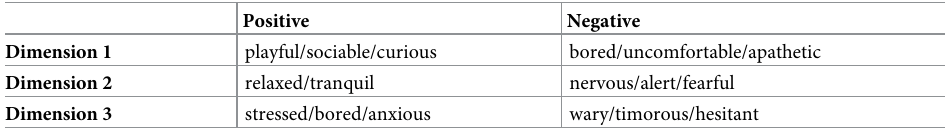
Table 1. List of terms summarising the highest positive and negative loadings on each consensus dimension gen- erated through Free Choice Profile methodology in Arena et al.